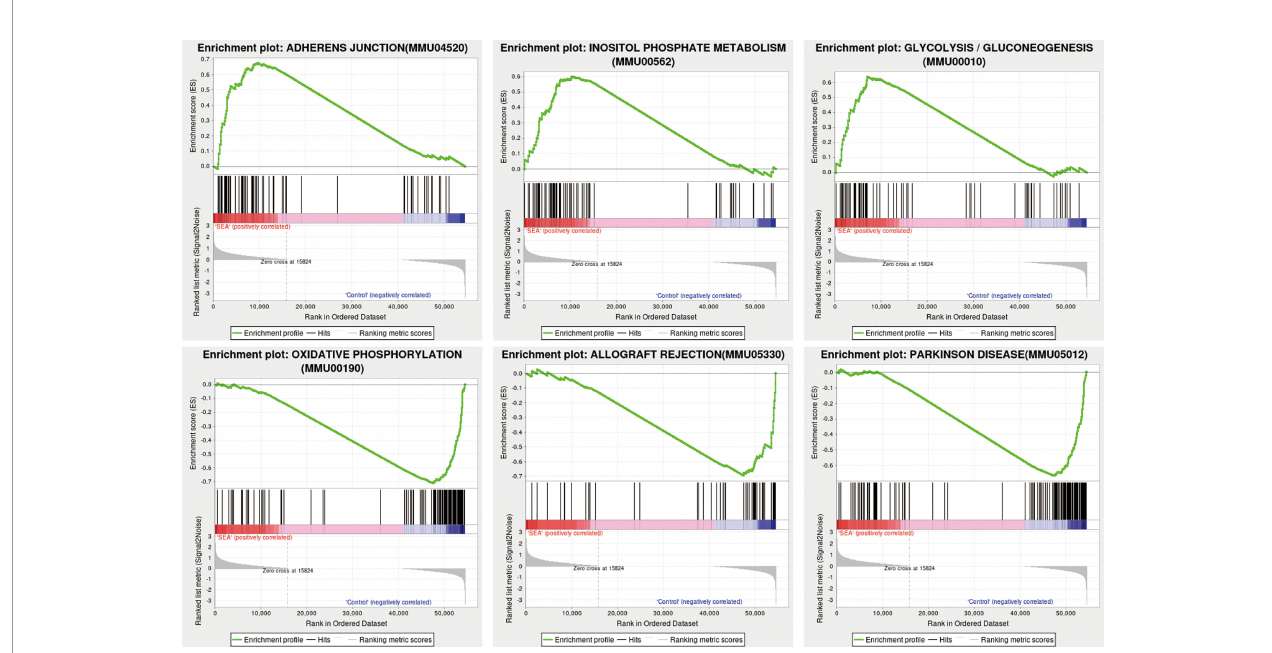
FIGURE 4 | GSEA in Sj SEA-treated skin graft. We screened and analyzed 22 upregulated pathways and 22 downregulated pathways based on |NES| > 1 and NOM p -value < 0.05. The upregulated enrichment pathways include adherens junction, glycolysis and gluconeogenesis, and inositol phosphate metabolism, among others. The downregulated pathways include oxidative phosphorylation, allograft rejection, Parkinson disease,